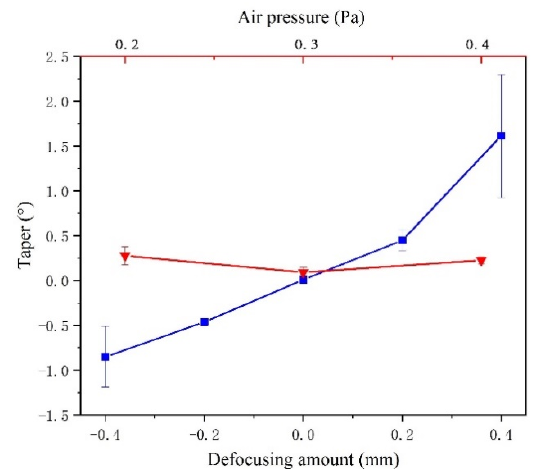
Figure 9. E ff ects of air pressure and defocusing amount on the microhole taper. Figure 9. Effects of air pressure and defocusing amount on the microhole taper.